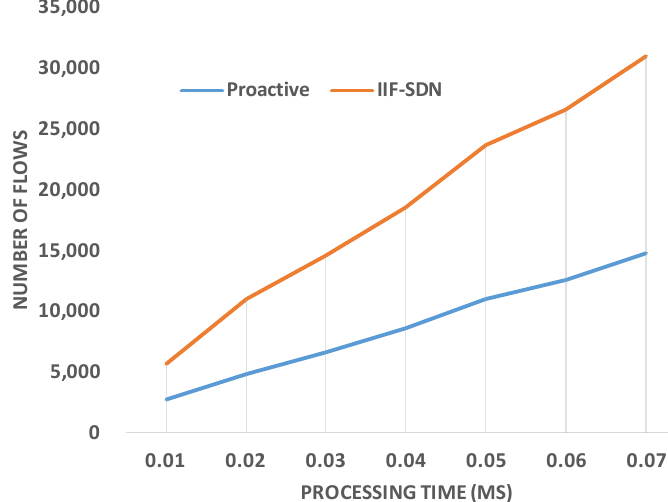
Figure 16. IIF-SDN (multiple nodes ’ flow-rule exchange).